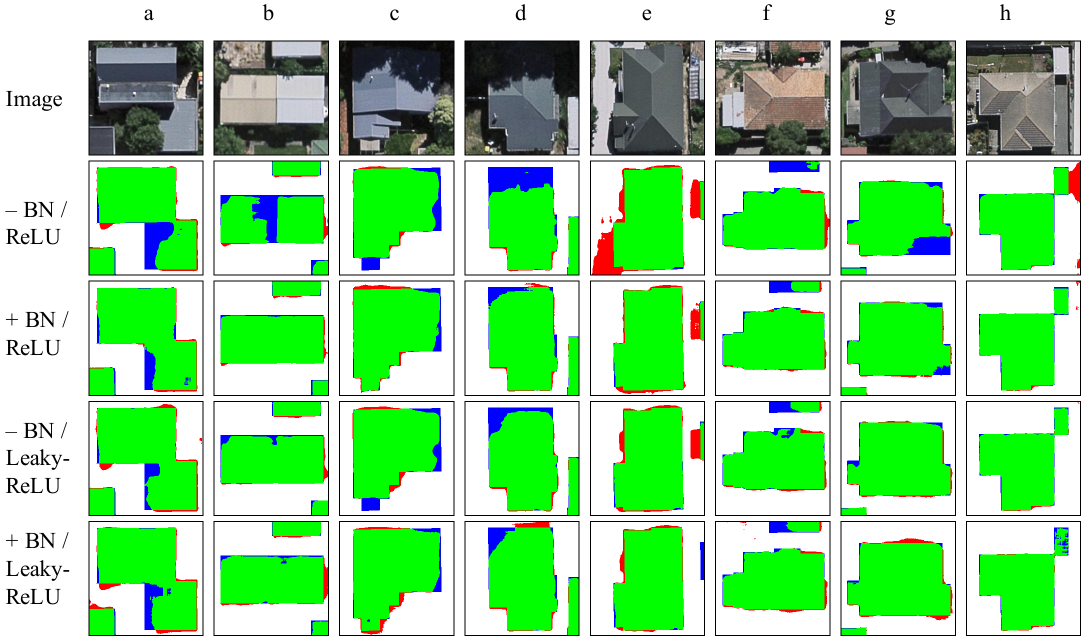
Figure 11. Representative results of single-building-level roof segmentation from BR-Net with various combinations of components. The green, red, blue, and white channels in the results represent true positive, false positive, false negative, and true negative predictions, respectively.